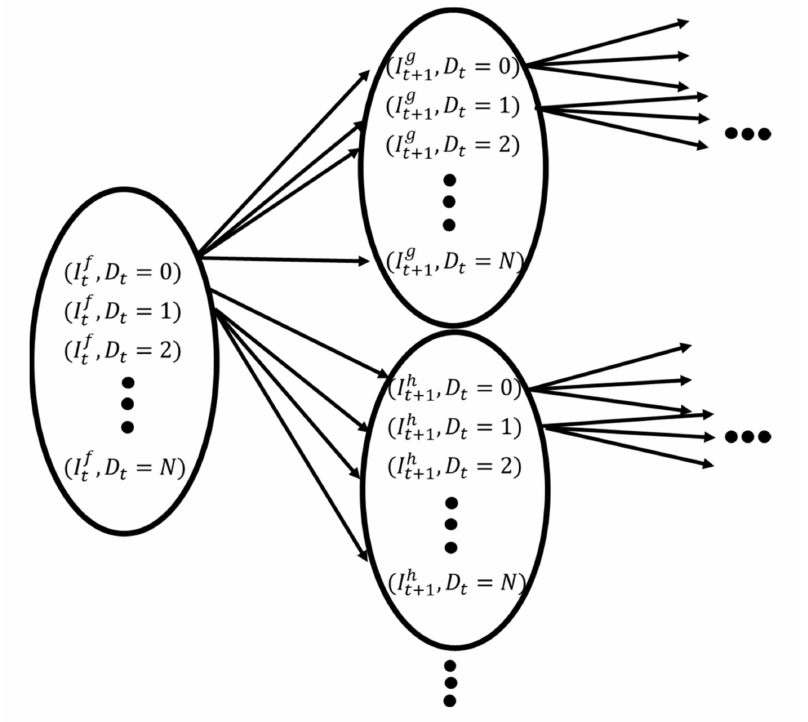
Figure 3. Grouped and ordered